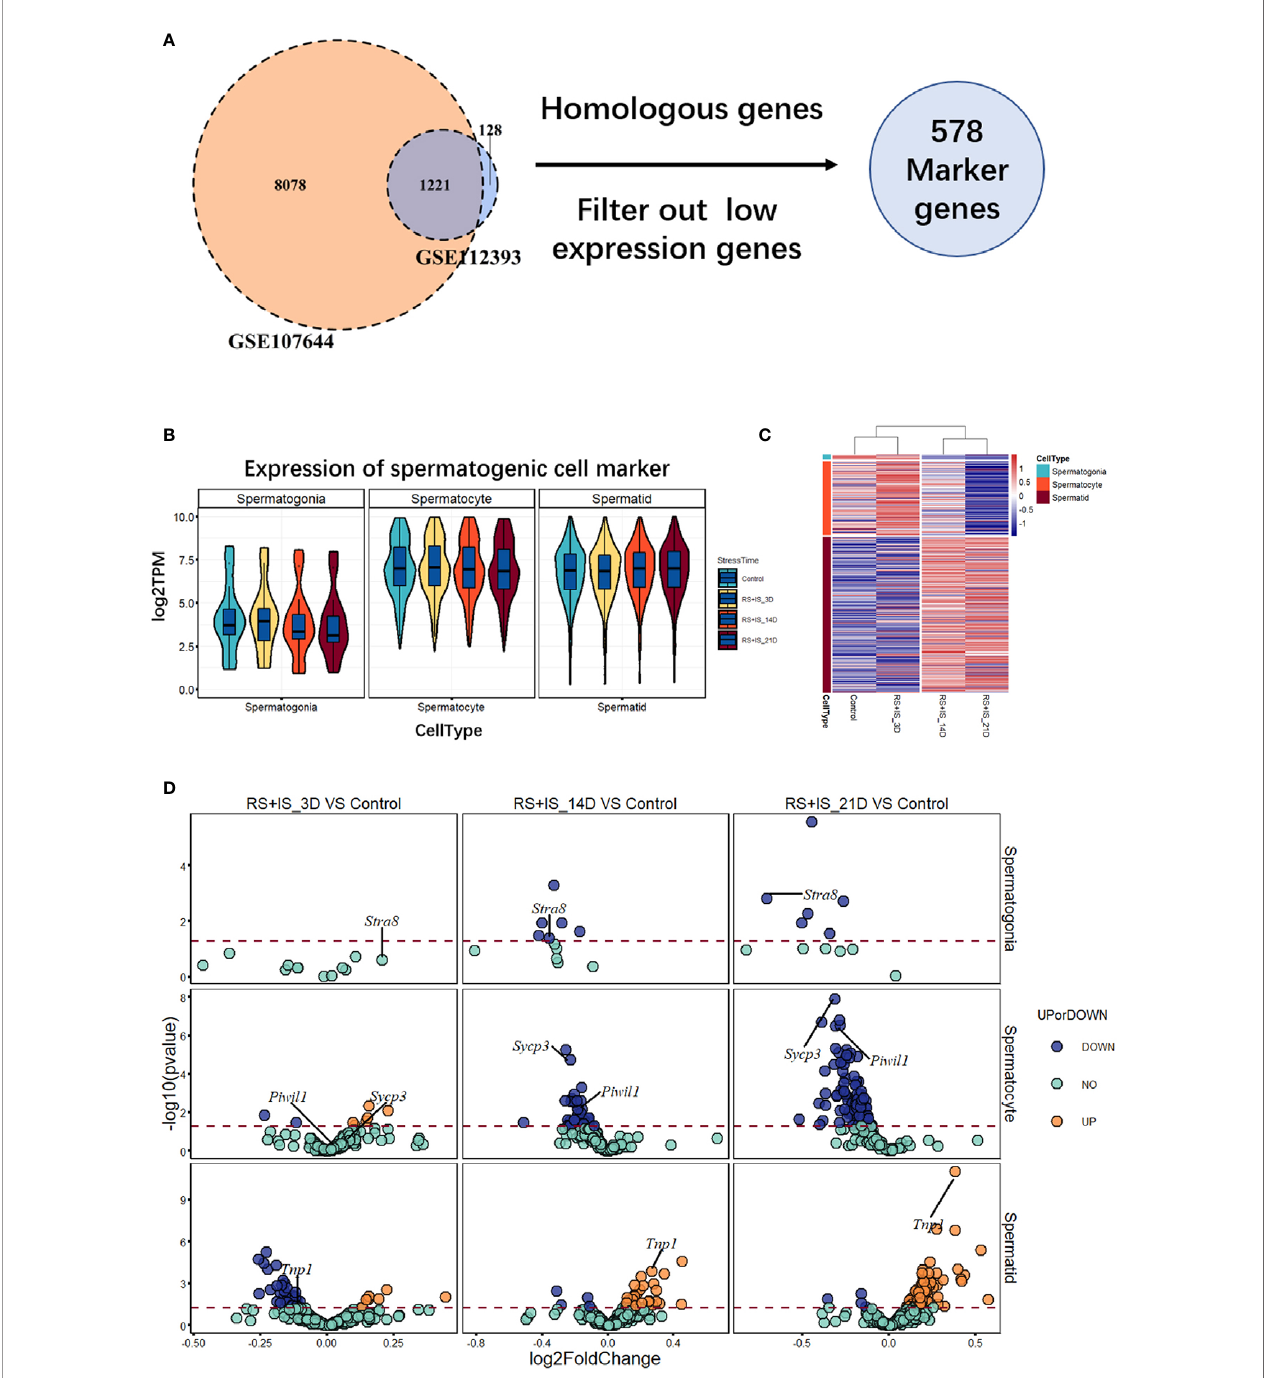
FIGURE 2 | Expression pro fi le of RNA-Seq data between normal and stress group. (A) 586 unique homologous markers were found. (B) Violin plots show average expression (from three biological replication) value of markers in different durations of RS+IS period. Each Violin plot represents the median, the fi rst quartiles, the third quartiles of gene expression value, and kernel probability density of the data at different values. (C) Cluster heat map (from three biological replication) of average germ cell marker expression in different durations of RS+IS period. (D) A volcano plot of different expression markers. The horizontal dot line means a p ‐ value of 0.05. The genes in blue ( P < 0.05, log2FoldChange < 0) or orange P < 0.05, log2FoldChange > 0) are signi fi cant different expression markers. No upregulated SPG and SPC markers were found at 14-day and 21-day stress group. Tagged genes were used for further veri fi